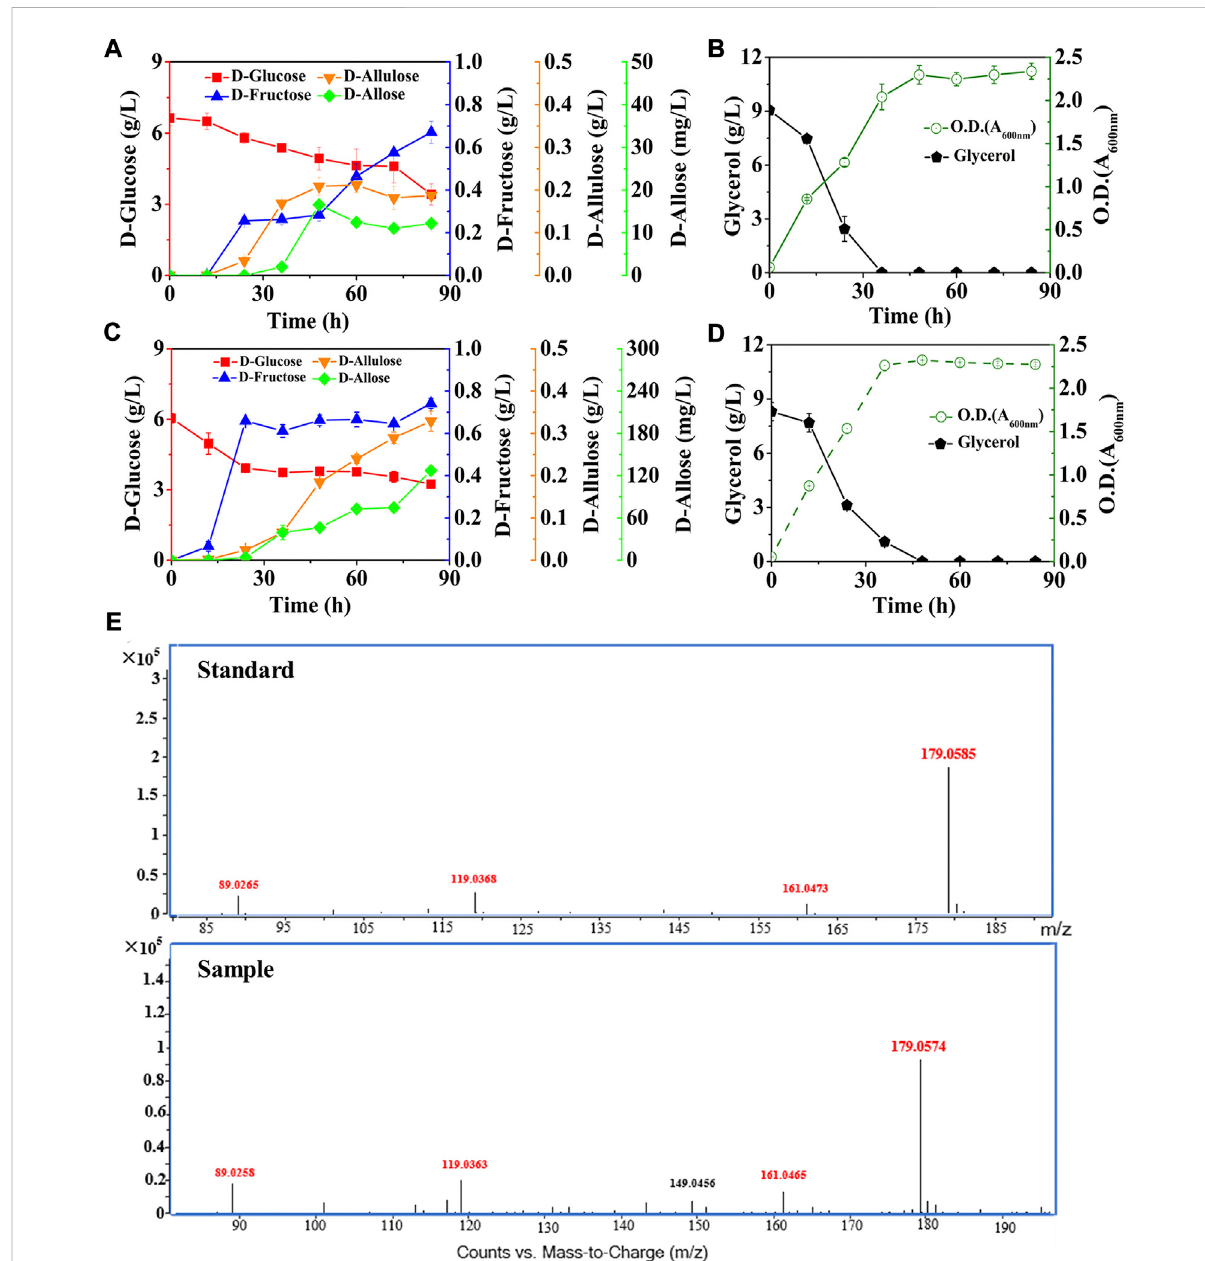
FIGURE 5 Deletion of D-allose transporter to improve the performance of cell factory. E. coli cells were cultured in M9 medium with D-glucose and glycerol at 30 ° C. (A) and (B) E. coli (DGI, DAE, RPI, GalP, Δ FruA, Δ PtsG, Δ Glk, Δ Mak, Δ PfkA, and Δ PfkB). (C) and (D) E. coli (DGI, DAE, RPI, GalP, Δ